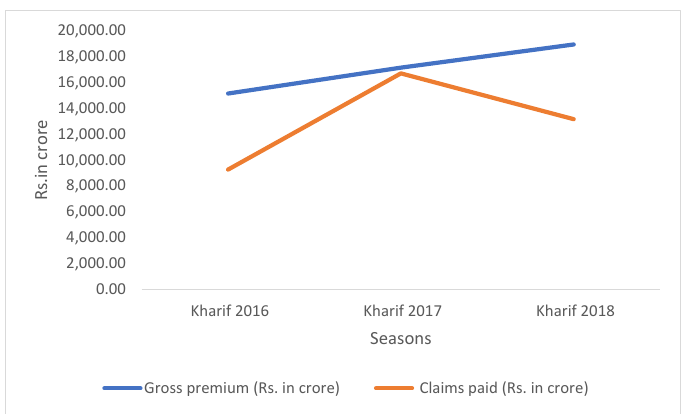
Figure 1. Gross premium collection amount and total amount of claims paid under PMFBY for kharif seasons (2016–2018). Source: Agriculture Statistics at a Glance (2017, 2018, 2019).